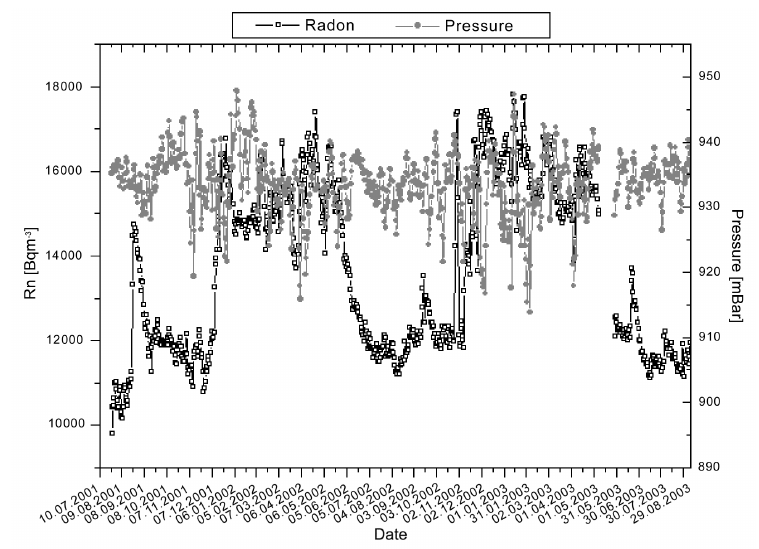
Fig. 3. Daily means of Radon concentration (open square) and of atmospheric pressure (full circle) in the Ve- na site; July 2001-September 2003.